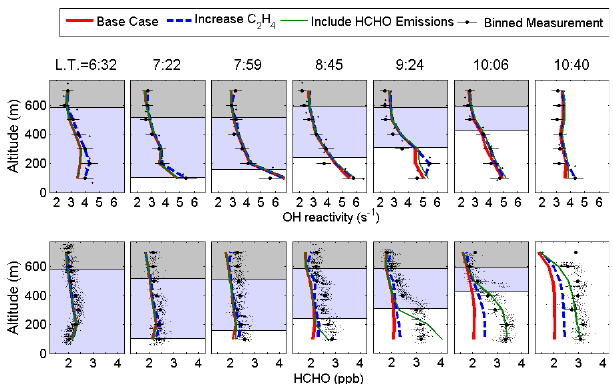
Figure 3. Measured and calculated OH reactivity and HCHO ver- tical profiles for every other Zeppelin ascent. Error bars on OH re- activity represent the measurement precision. Error bars on HCHO represent the standard deviation of the measurements in the given altitude bin. The gray, blue, and white areas represent the residual layer, the nocturnal boundary layer, and the mixed layer, respec- tively. Layer height was determined by the observed steep gradients in O 3 mixing ratios, as detailed in Li et al. (2014). Model scenarios are described in more detail in Sects. 3.2 and